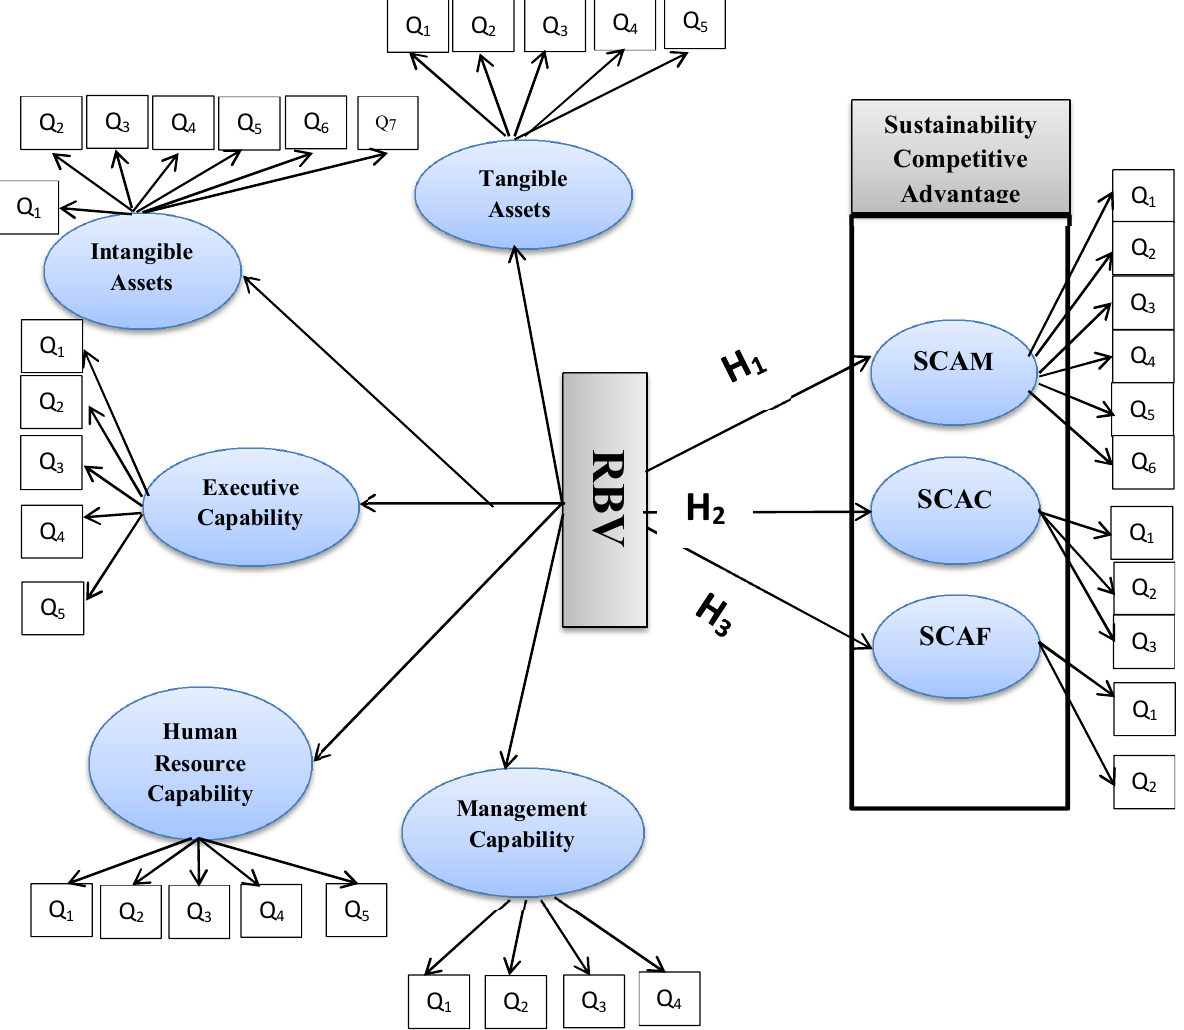
Fig. 1. Conceptual model between RBV and